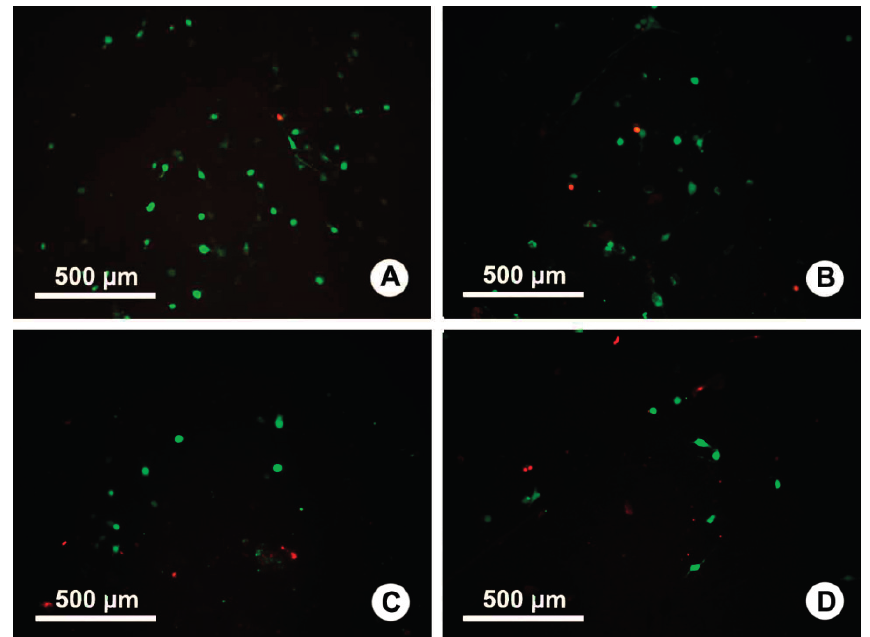
Figure 4. The results of a viability assay of C3H10T1/2 cells (C3) grown on the surface of PLLA ( A ); Ag4%–PLLA ( B ); Ag4%–IBU4%–PLLA ( C ); and Ag8%–PLLA ( D ). Red: dead cells; Green: live